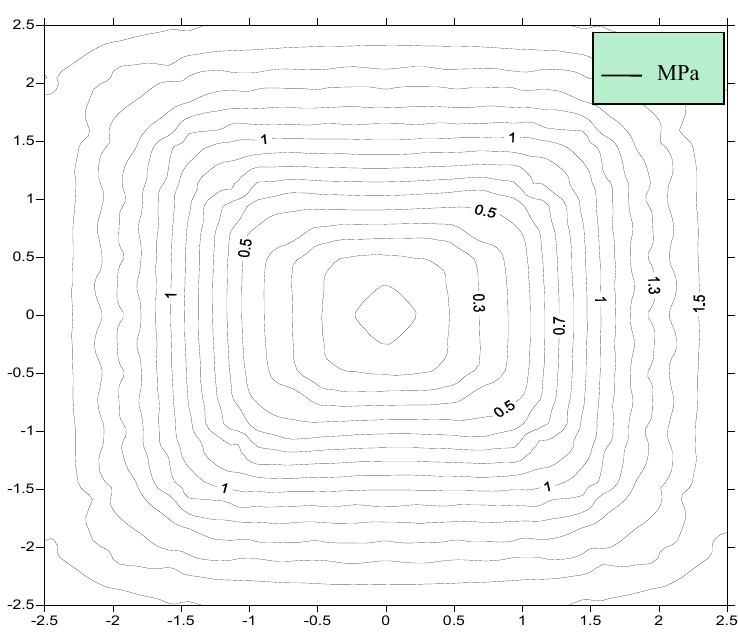
Figure 5. When T = 350 K, the distribution of gas pressure around boreholes.